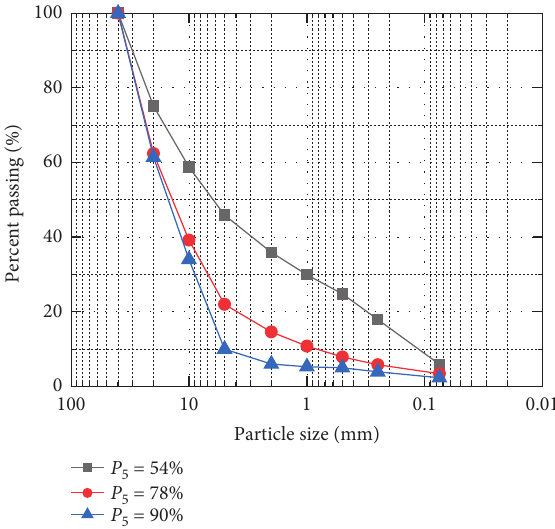
Figure 1: The gradation curves of soil-rock mixture. Table 1: The selected gradation of soil-rock mixture. Particle diameter